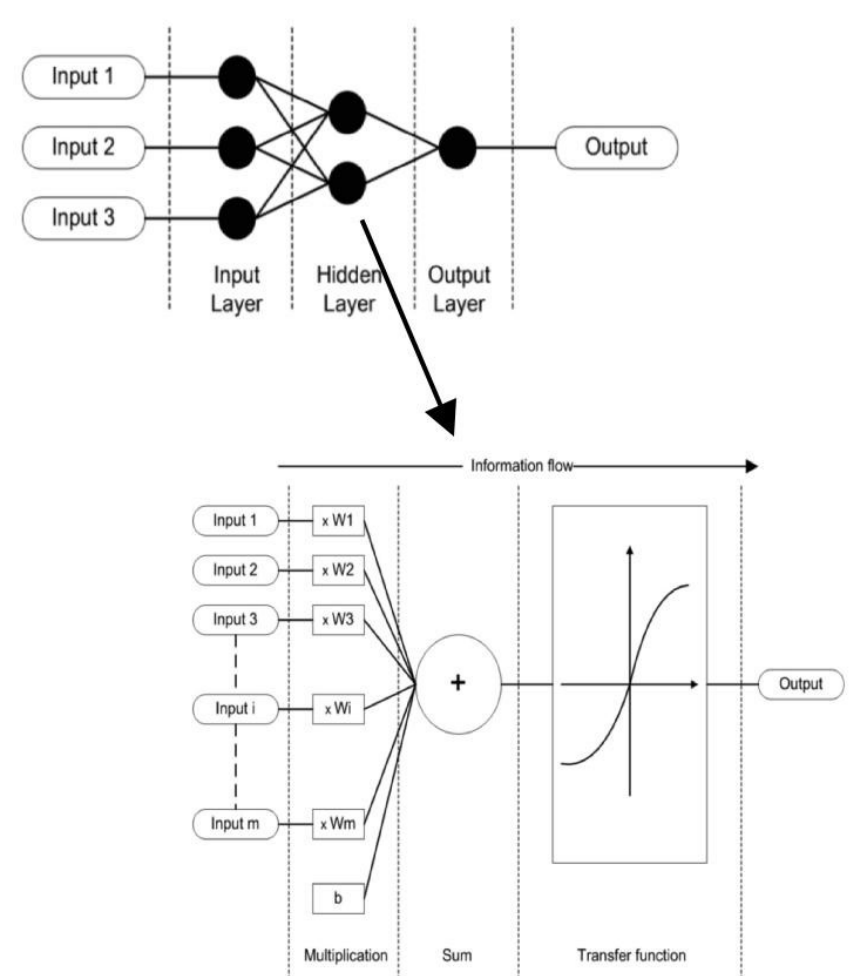
Figure 1. Simple Artificial Neural Network (ANN) with thebasic components of arificial neuron